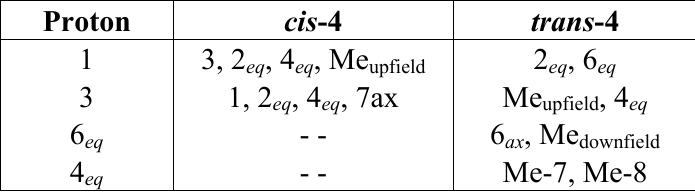
Table 2. NOE interactions for H